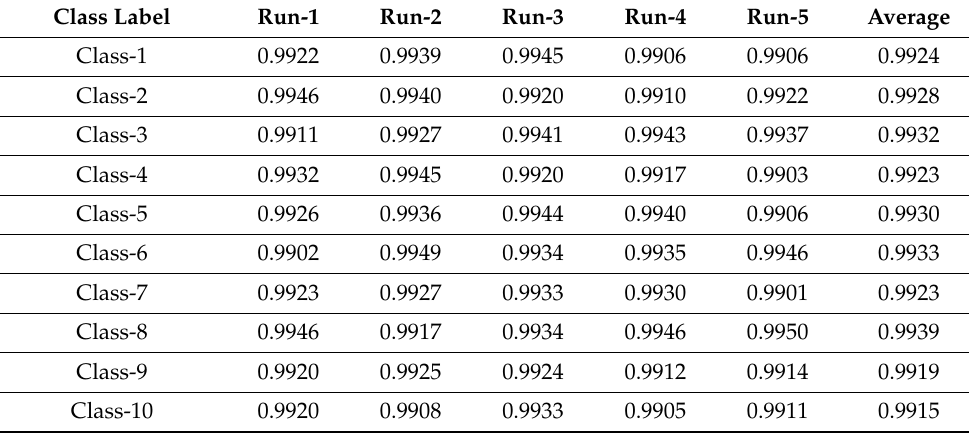
Table 4. Analytical results of SPOAI-FD technique under Bearing